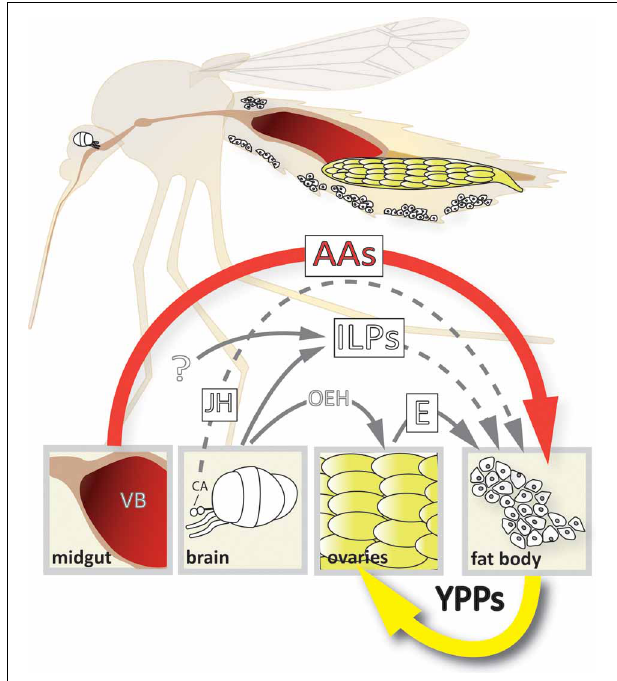
FIGURE 1 | Model of the 4-way regulation of YPP gene expression in Ae. aegypti . The upper part of the scheme depicts a longitudinal section showing the relative position of the different organs involved. Organ and cell size is not up to scale! The lower part shows the different signals involved and their origins. AAs, amino acids; CA, corpora allata; E, ecdysone; ILPs, insulin-like peptides; JH, juvenile hormone; OEH, ovary ecdysteroidogenic hormone; VB, vertebrate blood; YPPs, yolk protein